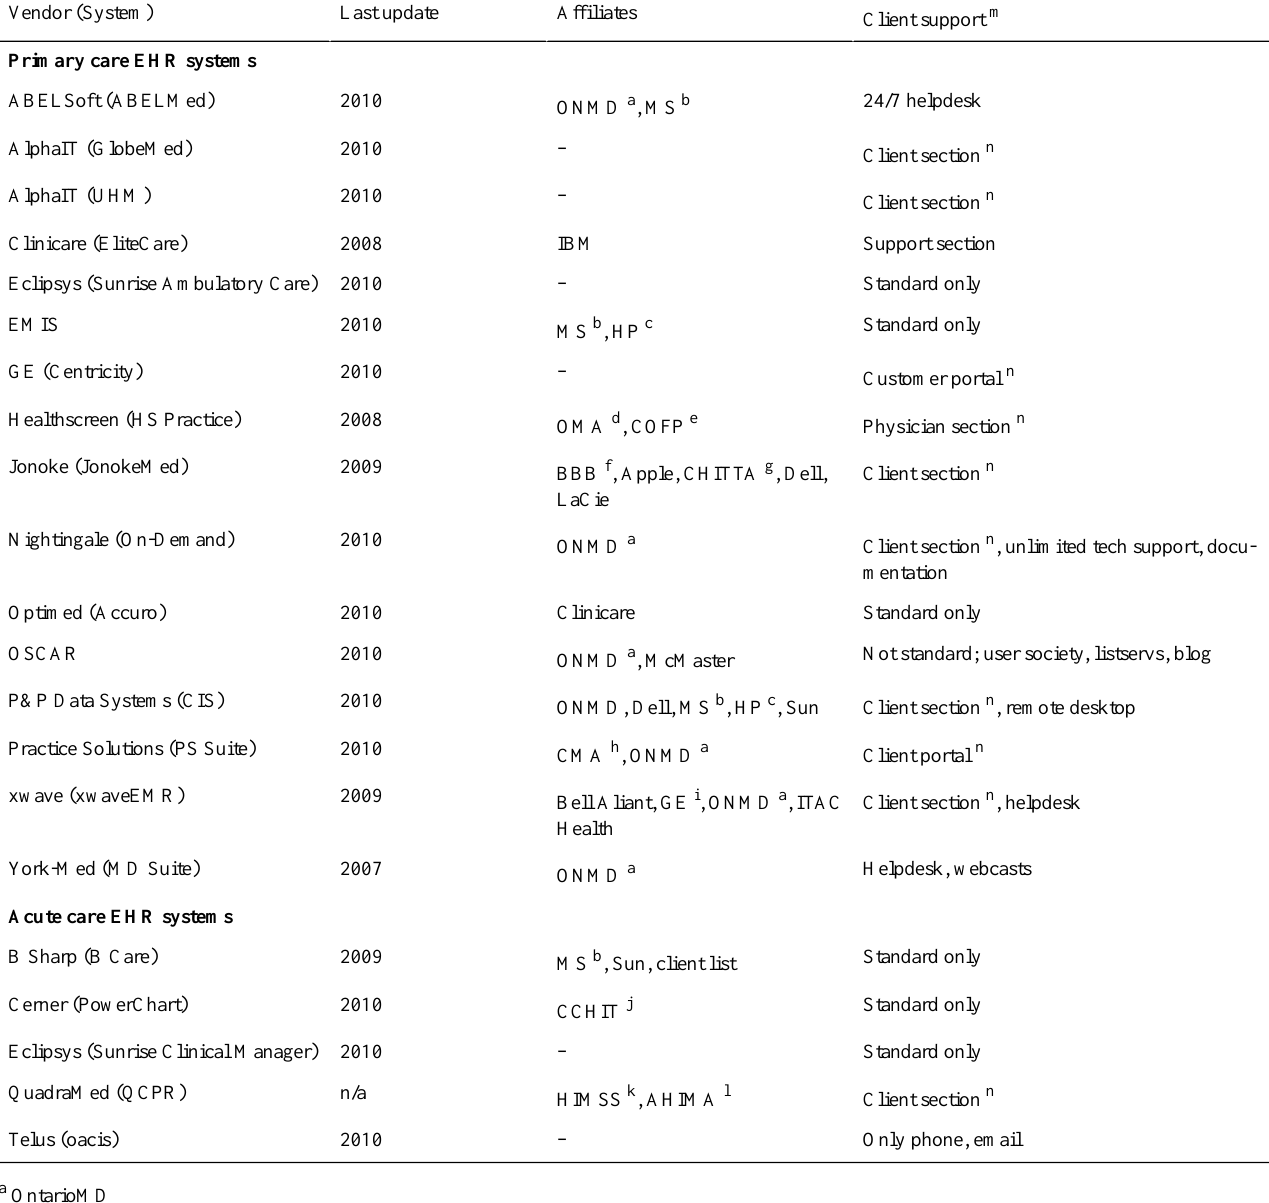
Table 3. Means for establishing consumer confidence presented on vendor